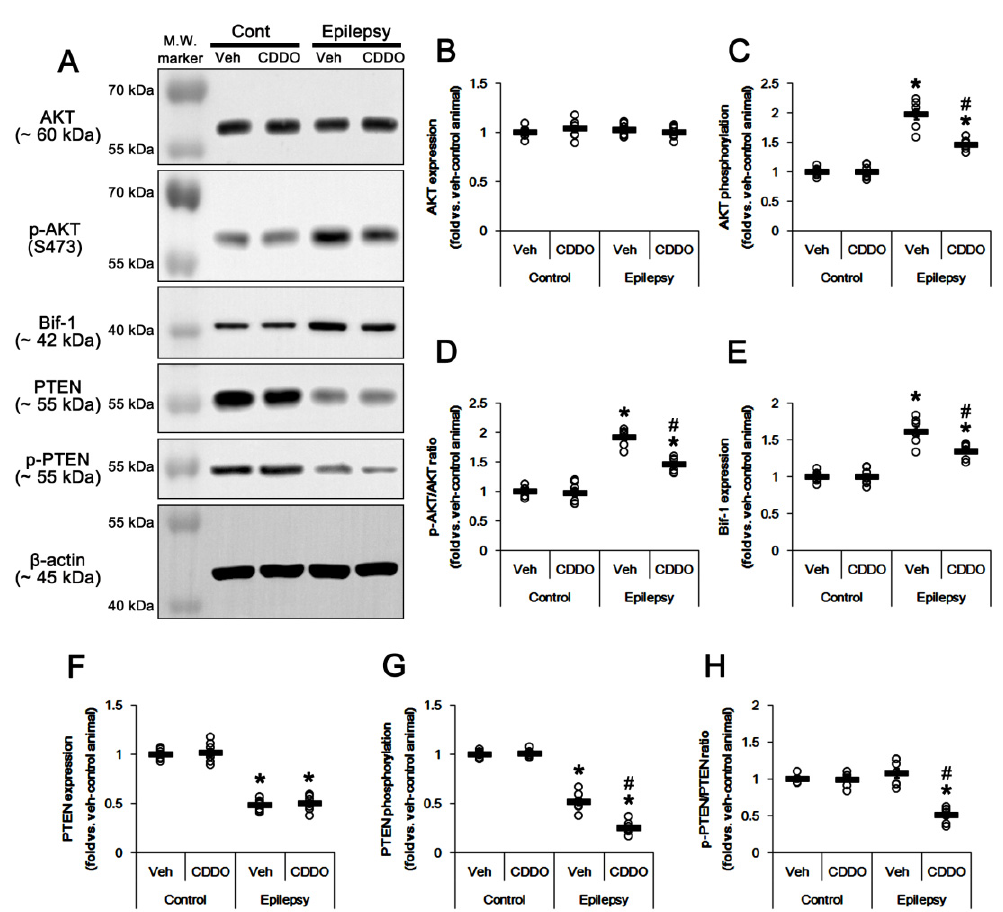
Figure 4. Effects of CDDO-Me on AKT, p-AKT, Bif-1, PTEN and p-PTEN levels in the CA1 region of control and epileptic rats. As compared to control animals (Cont), AKT-S473 phosphorylation and bax-interacting factor 1 (Bif-1) expression were lower in the CA1 region of epileptic rats. However, PTEN expression and its phosphorylation were also decreased in epileptic rats. CDDO-Me treatment attenuated the increases in AKT phosphorylation and Bif-1 expression in epileptic rats. In addition, CDDO-Me reduced p-PTEN level in epileptic rats without affecting its protein expression level. ( A ) Representative Western blot for AKT, p-AKT, Bif-1, PTEN and p-PTEN in the CA1 regions. (B–H ) Quantitative values (mean ± SEM) of protein, phosphorylation and phosphorylation ratio concerning AKT ( B–D ), Bif-1 ( E ) and PTEN ( F–H ) ( n = 7, respectively). Open circles indicate each value. Horizontal bars indicate the mean value. Significant differences are * ,# p < 0.05 vs. control animals and vehicle-treated animals.